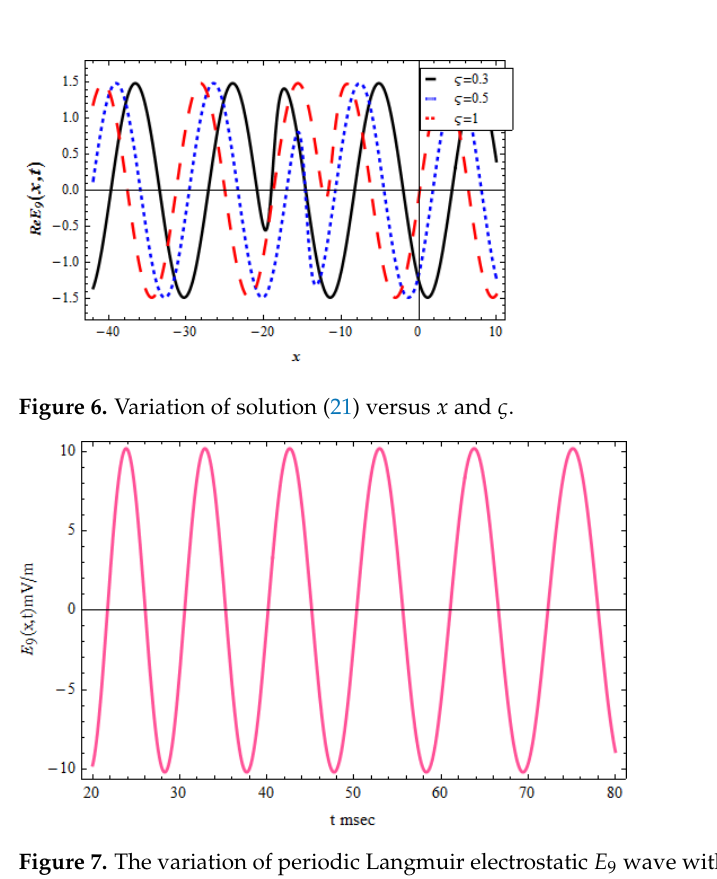
Figure 7. The variation of periodic Langmuir electrostatic E 9 wave with t